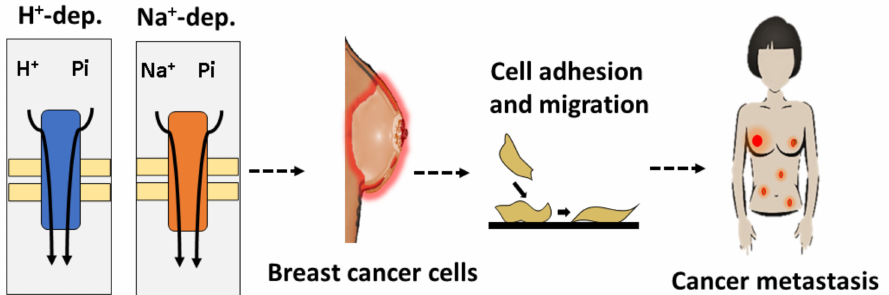
Figure 2. Schematic of the role of sodium-independent Pi transport in the development of breast cancer. Na + -independent Pi transport and Na + -dependent Pi transport in breast cancer cells promote cell adhesion and migration, which are important for maintaining cancer metastasis